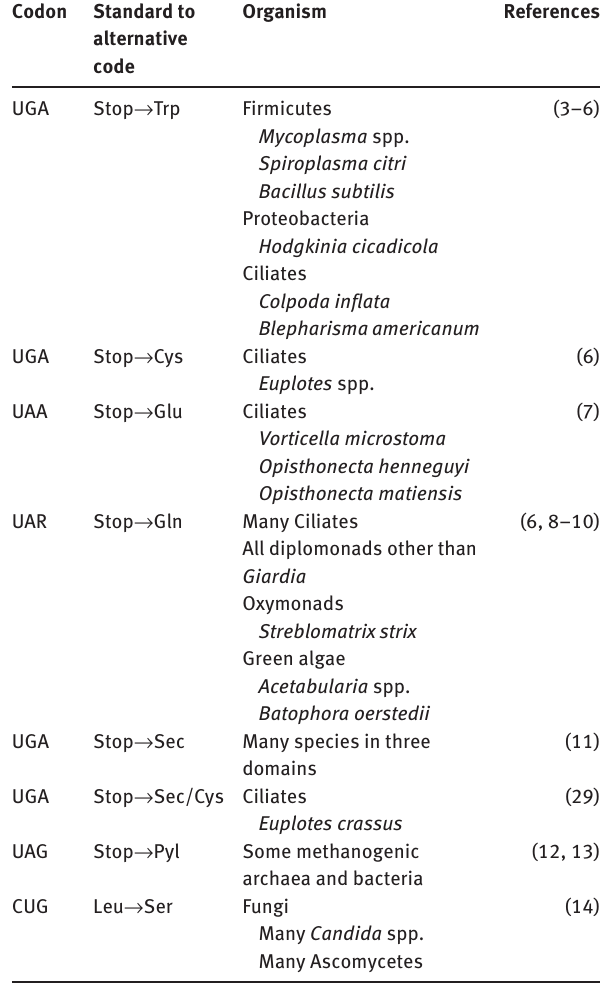
Table 1 Summary of nuclear genetic code